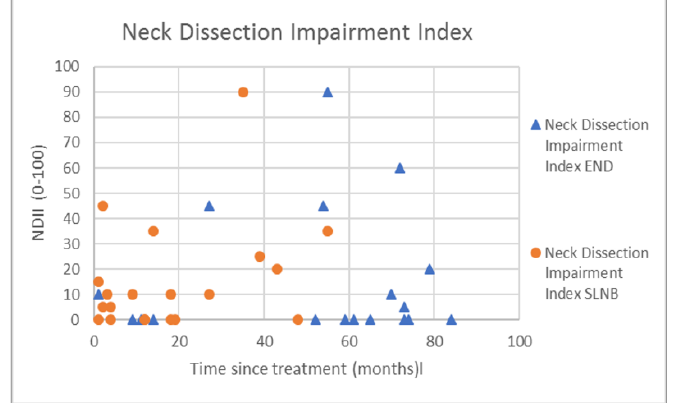
Figure 4. Neck dissection impairment index (NDII) in relation to time since treatment.